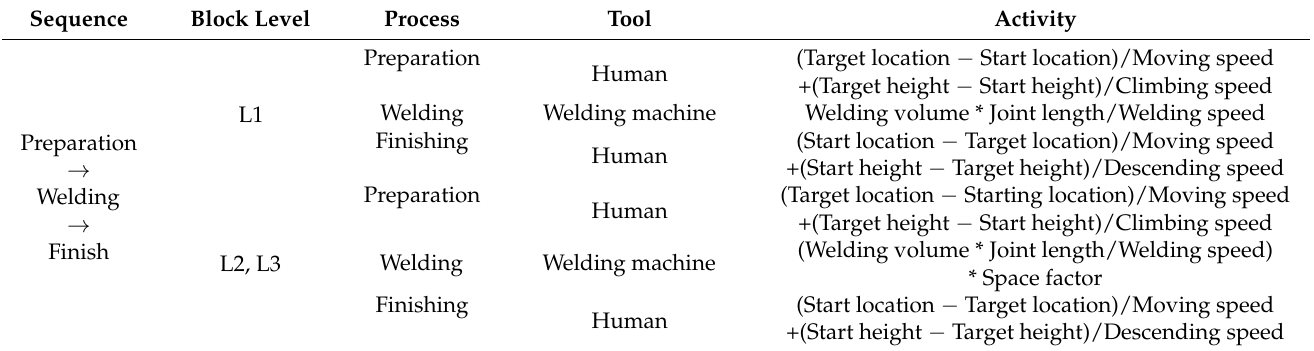
Table 4. Detailed procedure of main welding